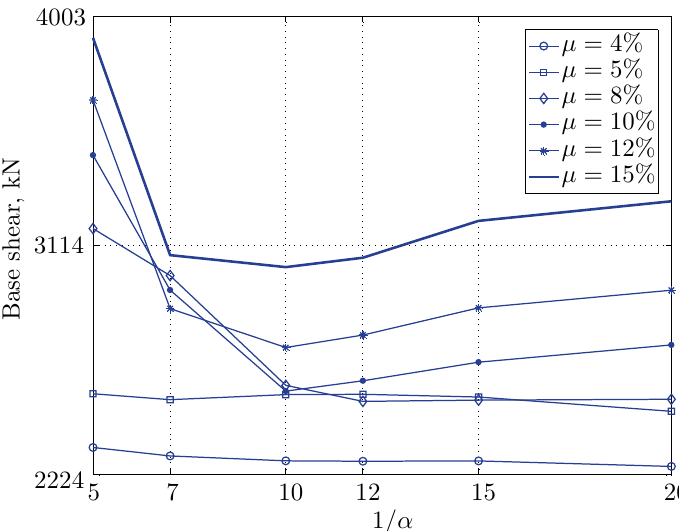
Figure 43. Maximum base shear for various isolation system parameters